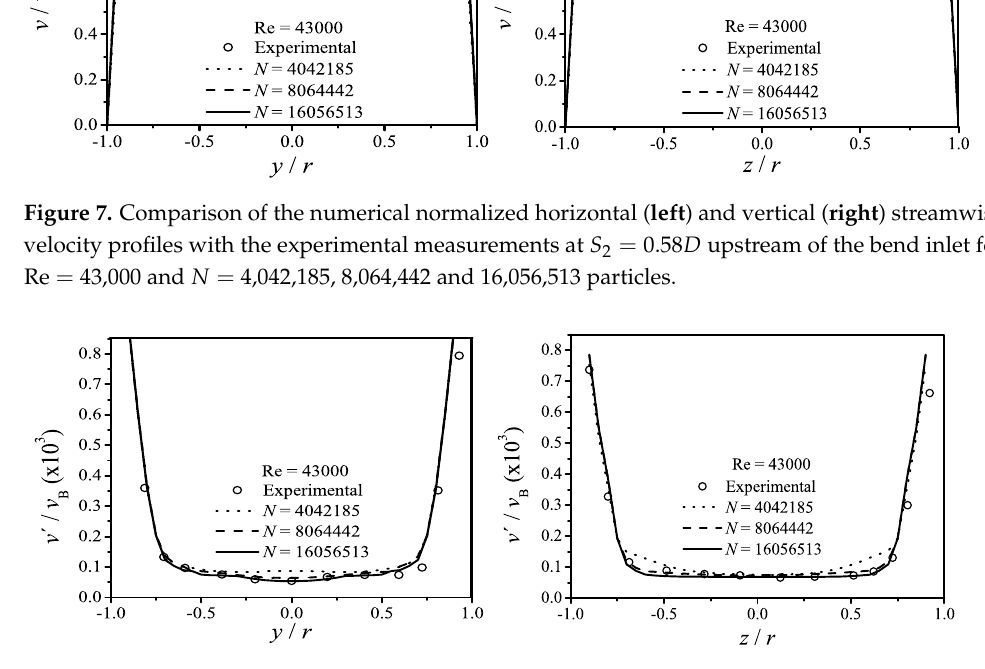
Figure 8. Comparison of the numerical normalized horizontal ( left ) and vertical ( right ) turbulence intensity profiles with the experimental measurements at S 2 = 0.58 D upstream of the bend inlet for Re = 43,000 and N = 4,042,185, 8,064,442 and 16,056,513 particles. Cross-sectional maps of the streamwise velocity are shown in Figure 9 for θ = 30 ◦ , 60 ◦ and 75 ◦ in the bend and in planes S 3 = 1 D and S 5 = 6 D downstream of the bend outlet. By the θ = 30 ◦ cross-sectional plane, the region of maximum velocity (potential core) was displaced towards the inside of the bend as a result of the adjustment of the flow to the cross-stream pressure gradient imposed by the bend curvature. This feature is in perfect agreement with the experimental contours of Enayet et al. (their Figure 9). At θ = 60 ◦ and 75 ◦ , the potential core looks highly distorted due to the presence of a strong swirling secondary flow, which is largely confined near the inner wall of the pipe where the velocity gradients are steeper and grows with distance through the bend. Close to the bend exit, the secondary flow extends over the entire cross-sectional area. However, downstream of the bend outlet, the transverse pressure gradients disappear, causing the velocity peak to move towards the outer wall as shown at pipe station S 3 = 1 D . In contrast to laminar flow, where a C-shaped core forms within the bend, in turbulent flow, the core becomes C-shaped at the exit of the pipe bend. The secondary flow persists down the straight pipe section and at station S 5 the potential core embraces most of the pipe circular cross-section and deforms into a well-pronounced horseshoe